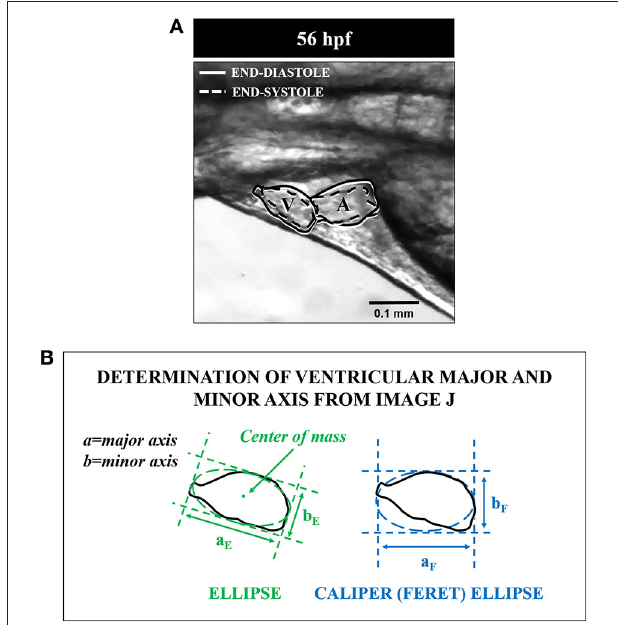
FIGURE 2 | Determination of major and minor ventricular axes from two ellipsoid models established using ImageJ software in 56 hpf mahi. The (A) shows the actual images of the ventricle during end-diastole (solid line) and end-systole (dashed line). The (B) shows the different variables used in measurement of both a simple ellipse and a caliper ellipse. See text for further details. a E and b E represent minor and major axis for standard ellipse; a F and b F represent minor and major axis for caliper ellipse.